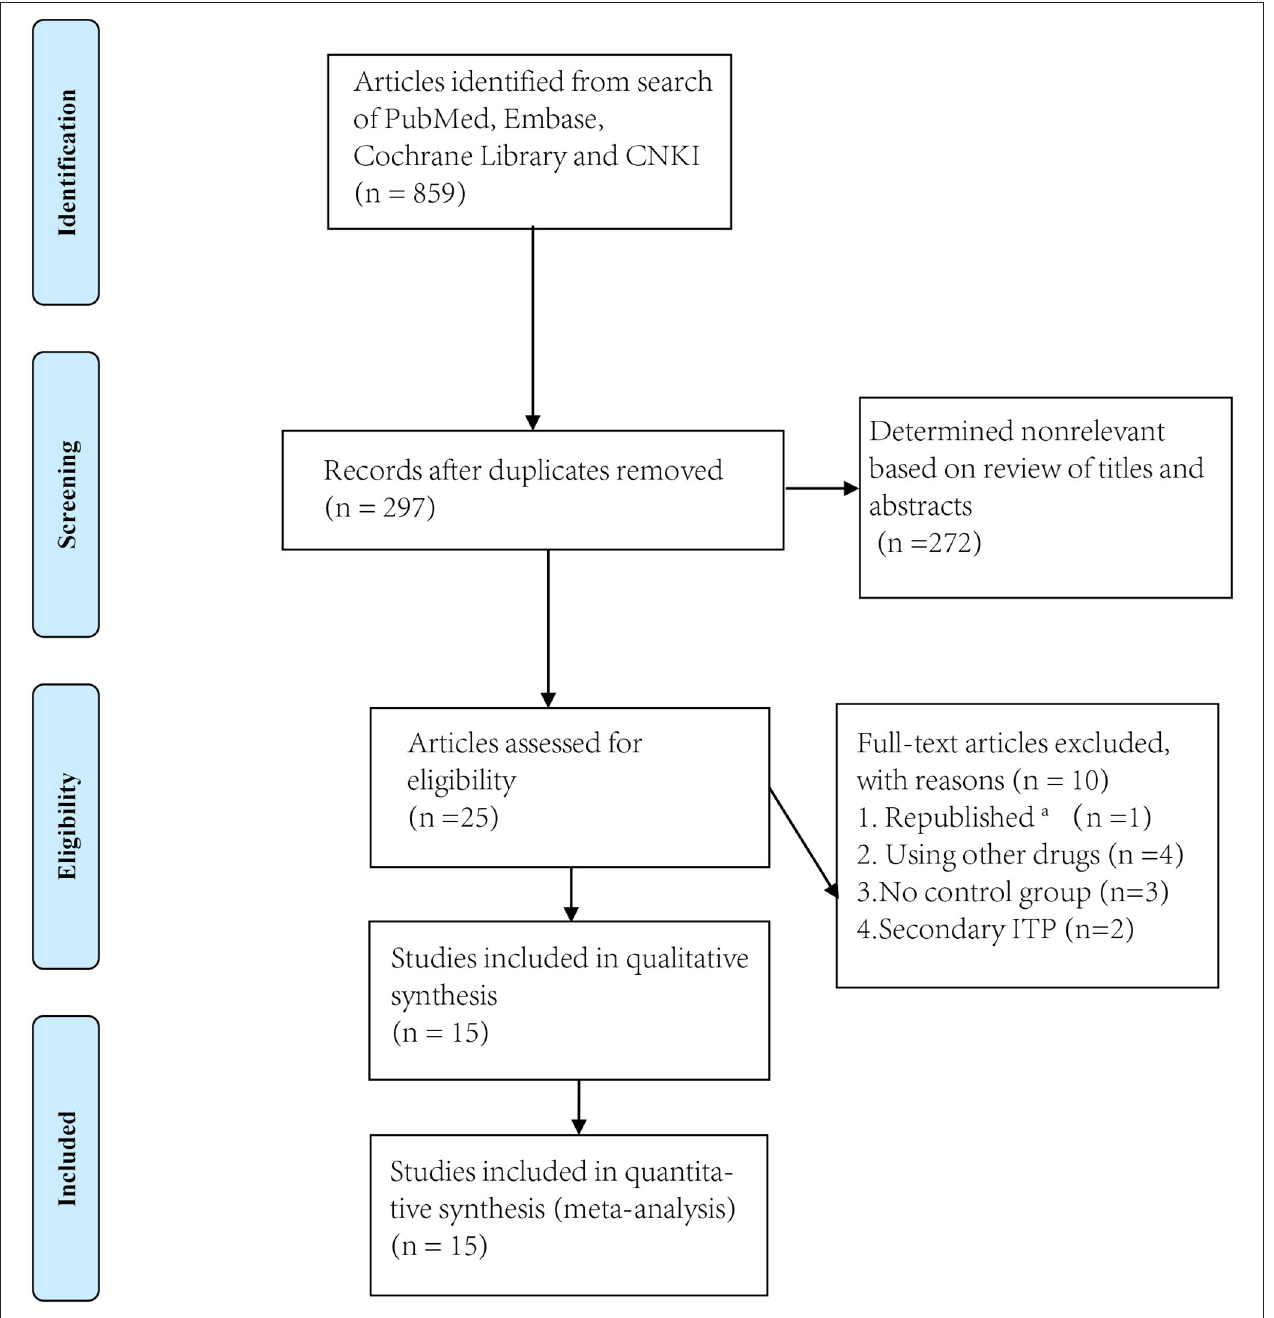
FIGURE 1 | Flowchart of study screening and selection process. a The most updated report was included.